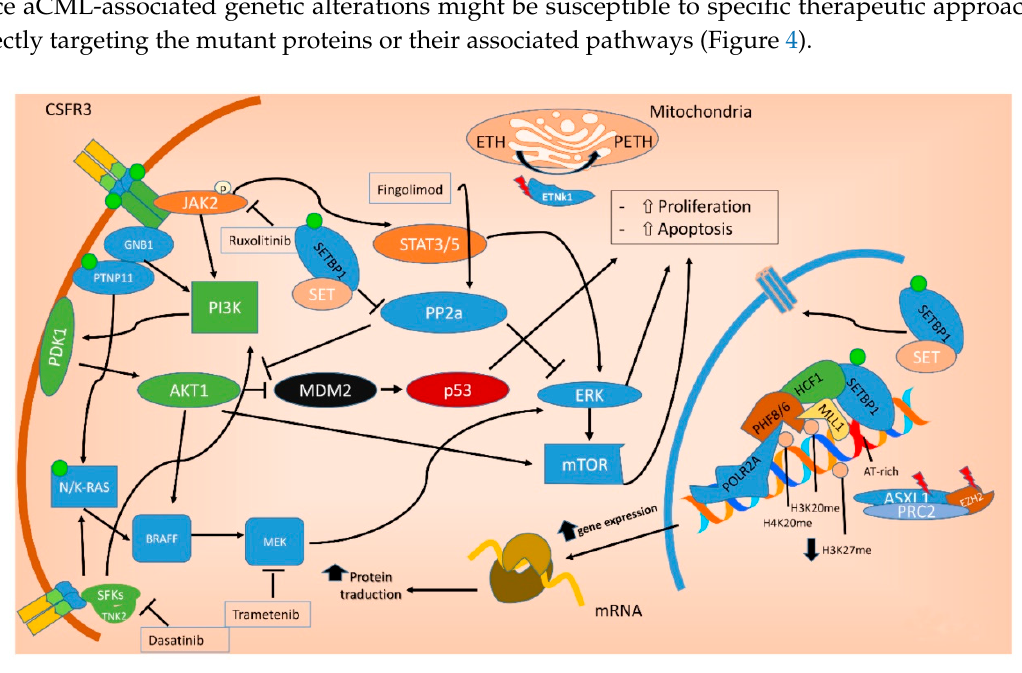
Figure 4. Molecular pathways involved in aCML. Mutations in the ASXL1 and EZH2 genes are mainly point mutations that lead to impaired function of the polycomb repressive complex 2 (PRC2), which translate in decreased epigenetic repression of key genes involved in stem cell renewal, thus promoting myeloid proliferation and differentiation. Mutations of both NRAS and PTNP11 result in a constitutive activation of MAPK, promoting cancer cell survival and proliferation. SETBP1 encodes a protein named SET binding protein 1 (SEB) that regulates the SET inhibitory activity on tumor suppressors, including PP2A. In aCML, all the SETBP1 mutations result in an increased gene expression and, through SET, in a reduction of PP2A inhibitory activity on AKT and MAPK pathways, leading to increased cellular proliferation and survival. Fingolimod targets PP2A with an activating effect. ETNK1 encodes an ethanolamine kinase, which catalyzes the first step of the de novo phosphatidylethanolamine biosynthesis pathway, critical for regulating membrane architecture and the topology of transmembrane domains of membrane binding proteins. Due to the fact that the ethanolamine kinase 1 contributes to different processes in the cell, the mechanisms by which the mutant protein induces myeloproliferation have not yet been clarified. CSFR3 mutations may be membrane proximal mutations or truncation mutations or a combination of the two. All the activating missense mutations target the proximal domain leading to increased dimerization and activation of JAK-STAT pathway, sensitive to its kinase inhibitor ruxolitinib. Conversely, CSFR3 truncating mutations induce receptor signaling through SRC family kinase rendering the cells sensitive to the multikinase inhibitor dasatinib. Green dot: activating mutation; red lightning: inactivating mutations. ETH: Ethanolamine; PETH: phosphatidylethanolamine.